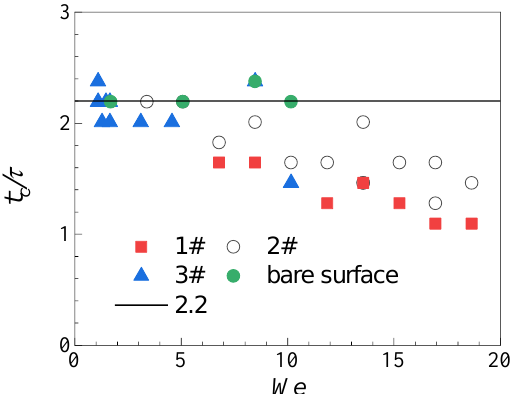
Figure 9. Normalized contact time of a droplet on the superhydrophobic mesh.